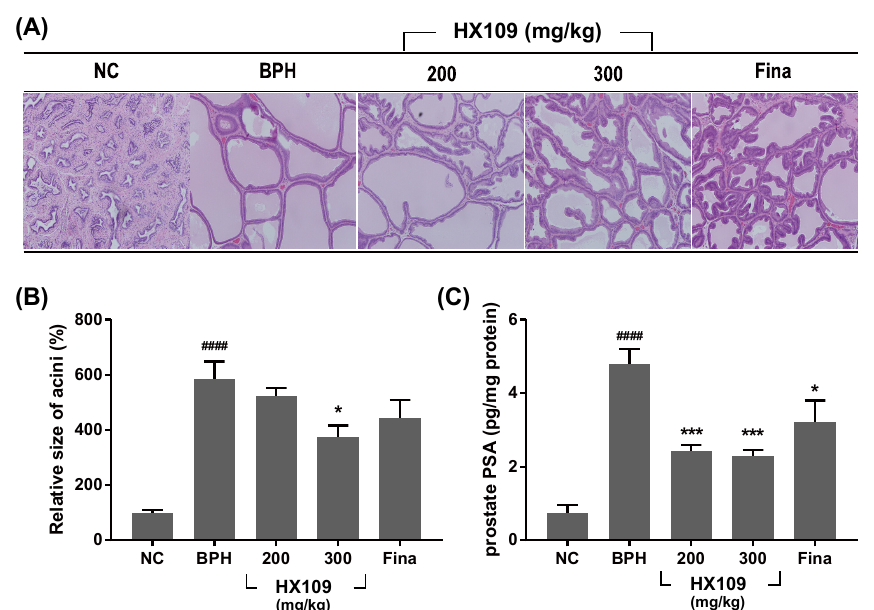
Figure 2. HX109 repressed TP-induced enlargement of prostate and PSA expression in rat prostate. Castrated Sprague Dawley rats were injected with 3 mg/kg every three days and orally administrated with TDW (BPH) or 200 mg/kg of HX109 or 300 mg/kg of HX109 or 5 mg/kg of finasteride (Fina). Rats injected with vehicle were used as a negative control (NC) group. ( A ) Effects of HX109 on histological changes in prostate. After measuring the final prostate weight, rats were sacrificed and prostate tissues were fixed, sectioned, and stained with hematoxylin and eosin (H&E). ( B ) Relative size of acinal area. Values were calculated from three randomly captured pictures. #### p < 0.0001 (one-way ANOVA) compared with the NC group, * p < 0.05 (one-way ANOVA) compared with the BPH group. All data are shown as mean ± S.E.M. ( C ) Effects of HX109 on prostate PSA levels. PSA levels of rat prostate were measured by ELISA. Values were normalized to total proteins. n = 5 per group. #### p < 0.0001 (one-way ANOVA) compared with the NC group, * p < 0.05, *** p < 0.001 (one-way ANOVA) compared with BPH group. All data are shown as mean ± S.E.M.